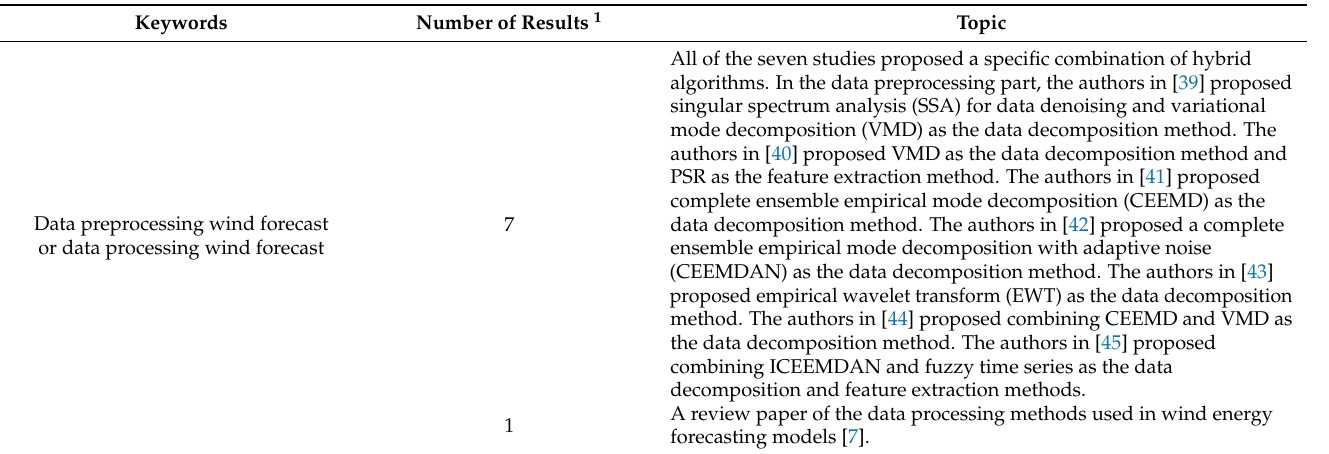
Table 2. Literature search results by relevant keywords in ScienceDirect and MDPI conducted on